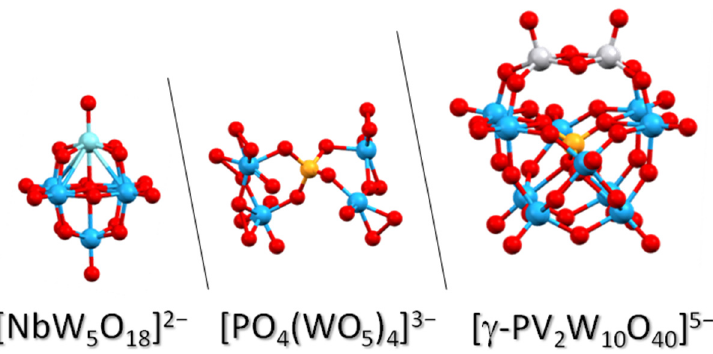
Figure 2. Structures of Lindqvist NbW 5 , Venturello PW 4 and Keggin γ− PV 2 W 10 polyoxometalates.